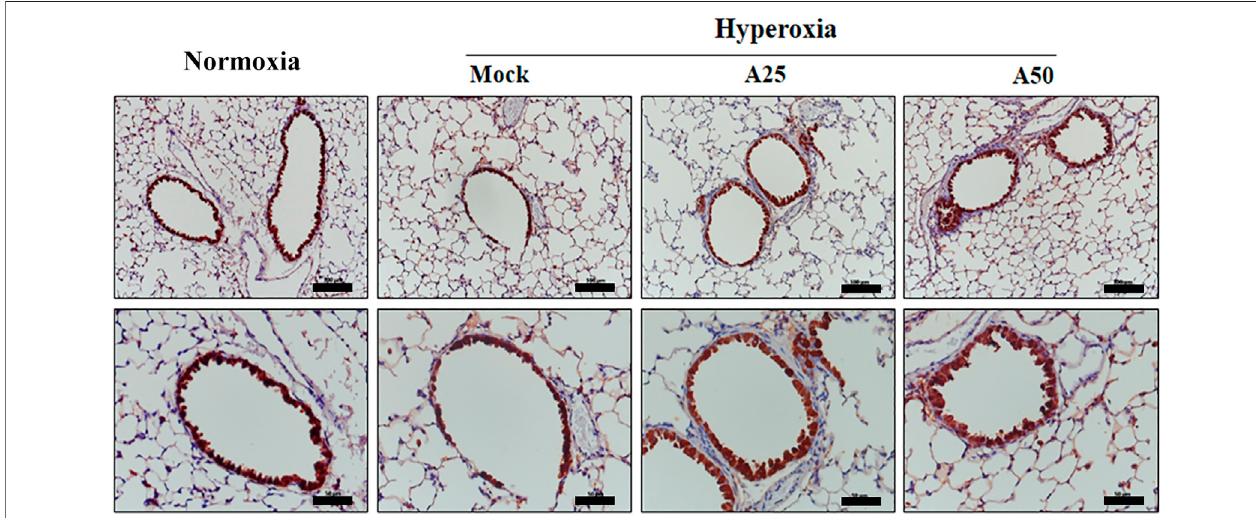
FIGURE7| Immunohistochemicalstainingindicatingthetherapeuticef fi cacyofaspirinat altering levels ofthe CC10proteinin NF- κ B-luciferase +/+ transgenic mice exposed to hyperoxia. Scale bars for the upper panel represent 200 µm and lower panel represent 50 µm. NF- κ B-luciferase +/+ transgenic mice were assigned to four groups ( n (cid:1) 6 mice per group): Mock group, treatment with PBS at 0, 24, and 48 h and exposure to hyperoxia for 72 h; A25 group, treatment with 25 μ g/g aspirin at 0, 24, and 48 h and exposure to hyperoxia for 72 h; A50 group, treatment with 50 μ g/g aspirin at 0, 24, and 48 h and exposure to hyperoxia for 72 h.